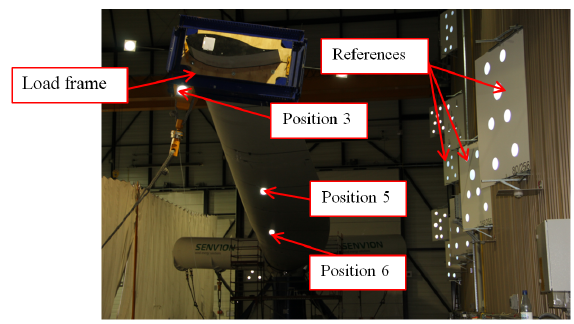
Figure 2. Optical position measurement.